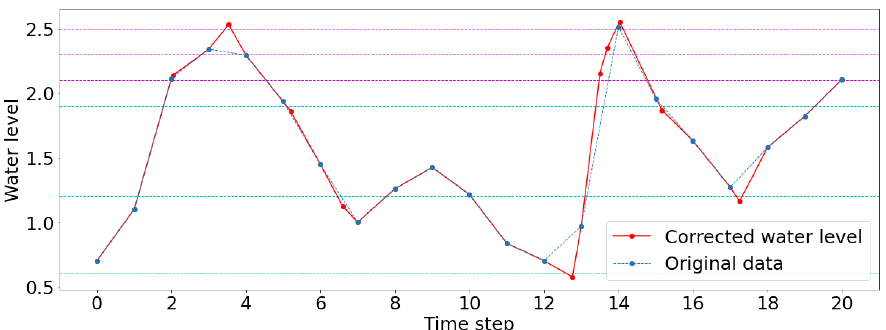
Figure 12. The water level for the first 20 entries of the sample, as given in the data set and by its correction using the modeling established in Section